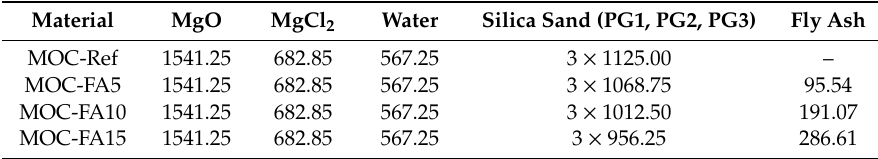
Table 3. Composition of magnesium oxychloride cement (MOC) composites (g).